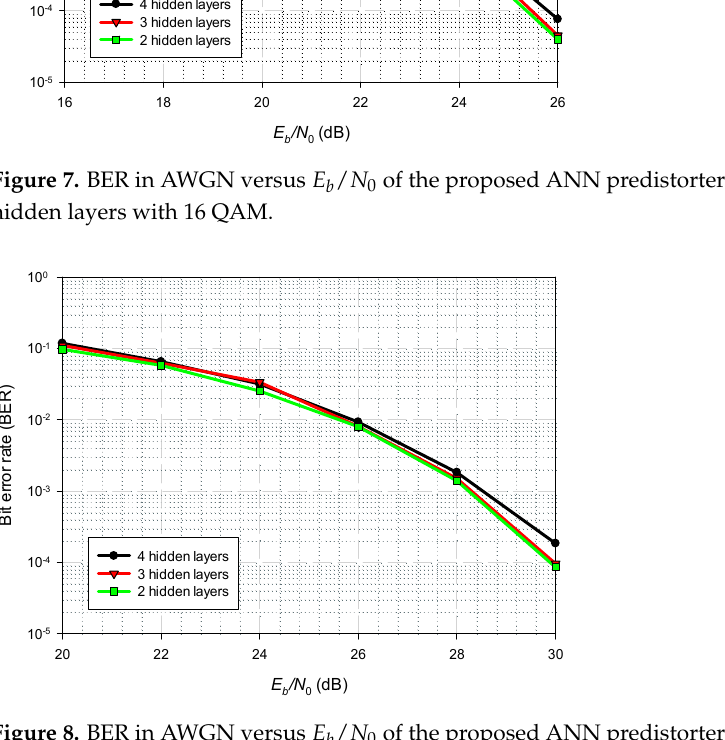
Figure 8. BER in AWGN versus E b / N 0 of the proposed ANN predistorter for different numbers Figure 8. BER in AWGN versus 𝐸 (cid:3029) /𝑁 (cid:2868) of the proposed ANN predistorter for different numbers of hidden layers with 64 QAM. Figure 8. BER in AWGN versus 𝐸 (cid:3029) /𝑁 (cid:2868) of the proposed ANN predistorter for different numbers of hidden layers with 64 QAM. Figure 8. BER in AWGN versus 𝐸 (cid:3029) /𝑁 (cid:2868) of the proposed ANN predistorter for different numbers of hidden layers with 64 QAM.